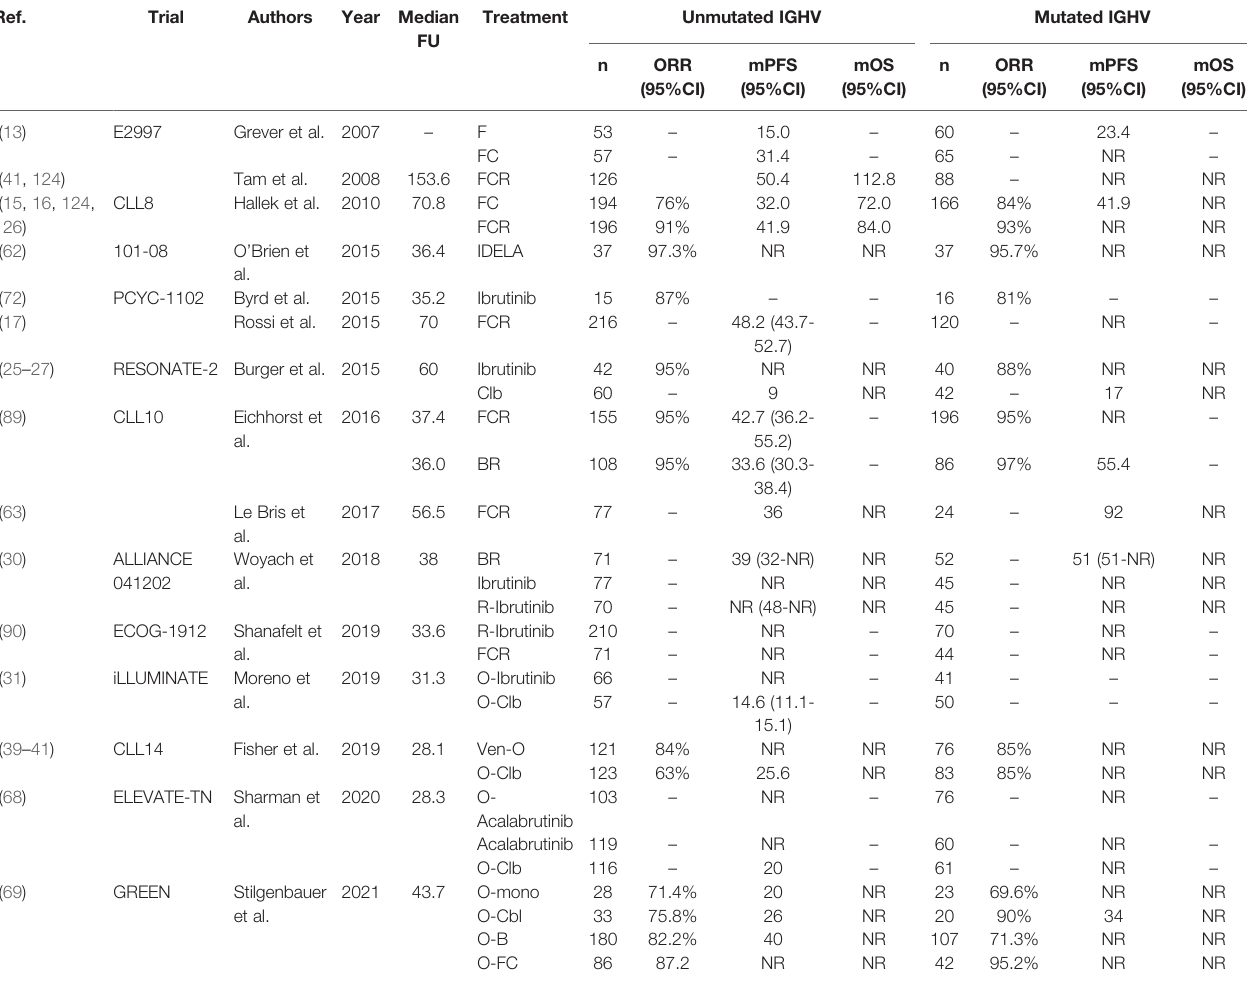
TABLE 6 | An overview of clinical trials comparing fi rst-line treatment regimens for patients with U-CLL.